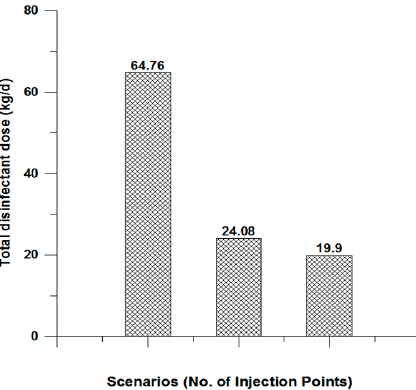
Figure 3. Changes in optimal injection amount by scenario.